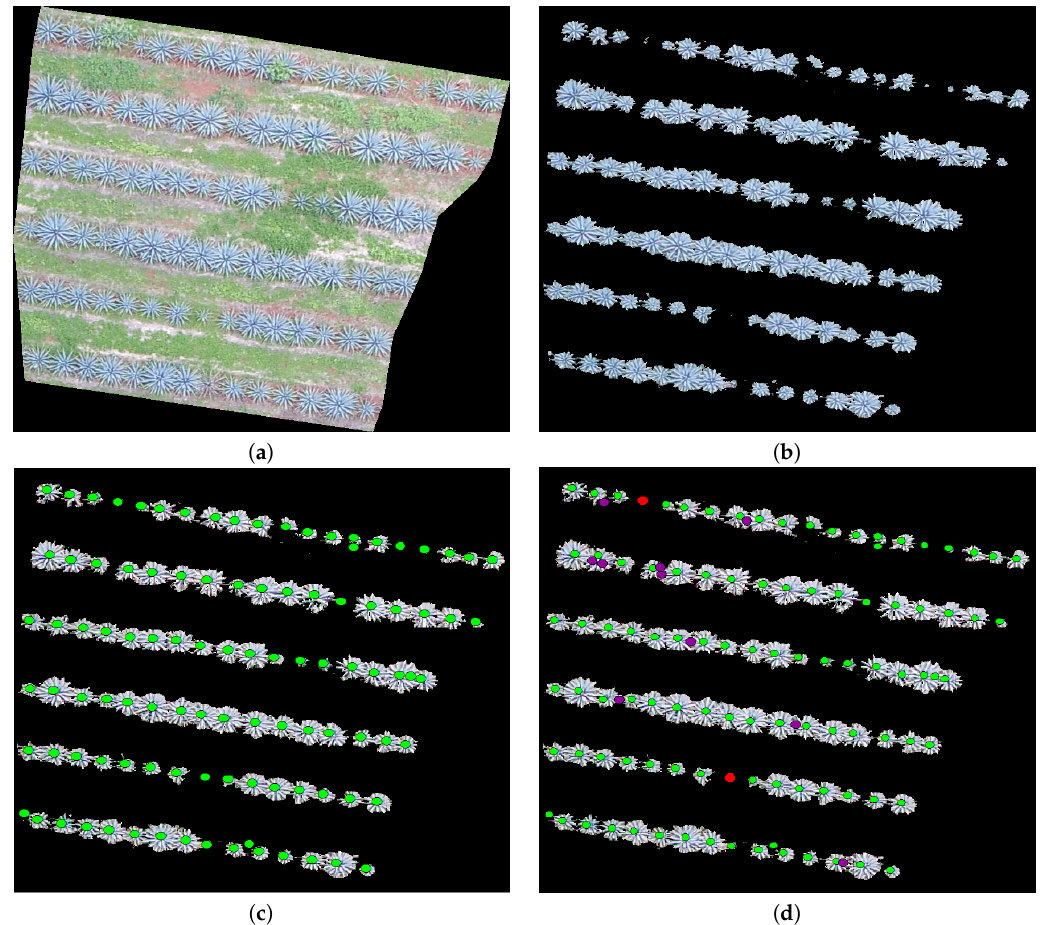
Figure 15. ( a ) A polygon in blue in Field 3 (Figure 4), ( b ) an extracted agave layer by means of the methodology in [2], ( c ) agave plants counted by an expert (ground truth), and ( d ) agave plants detected by the proposal; those not detected appear in red (false negative).